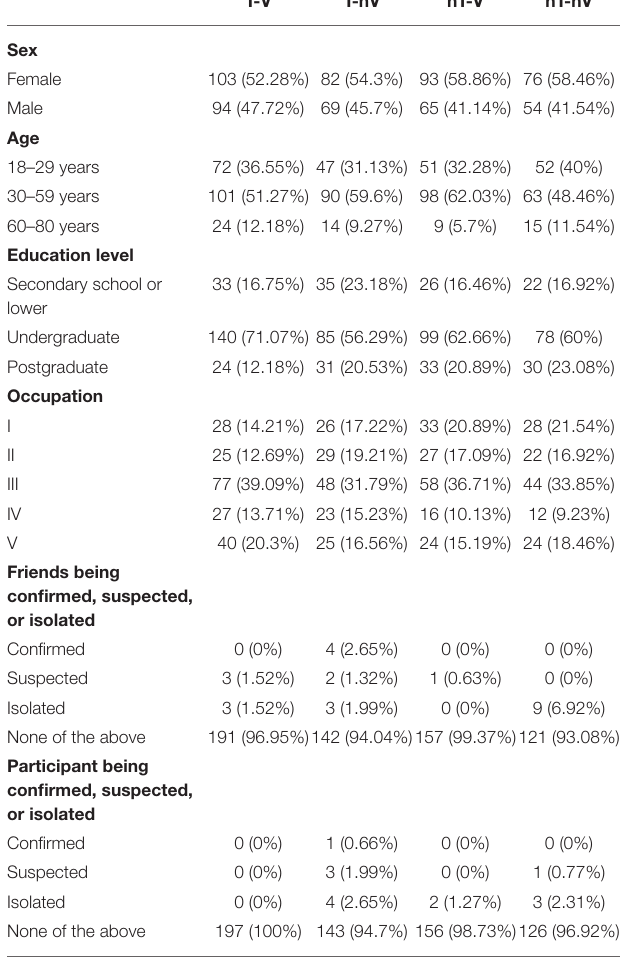
TABLE 2 | Demographic and socioeconomic characteristics of respondents. TABLE 3 | Factors associated with dental attendance during the COVID-19